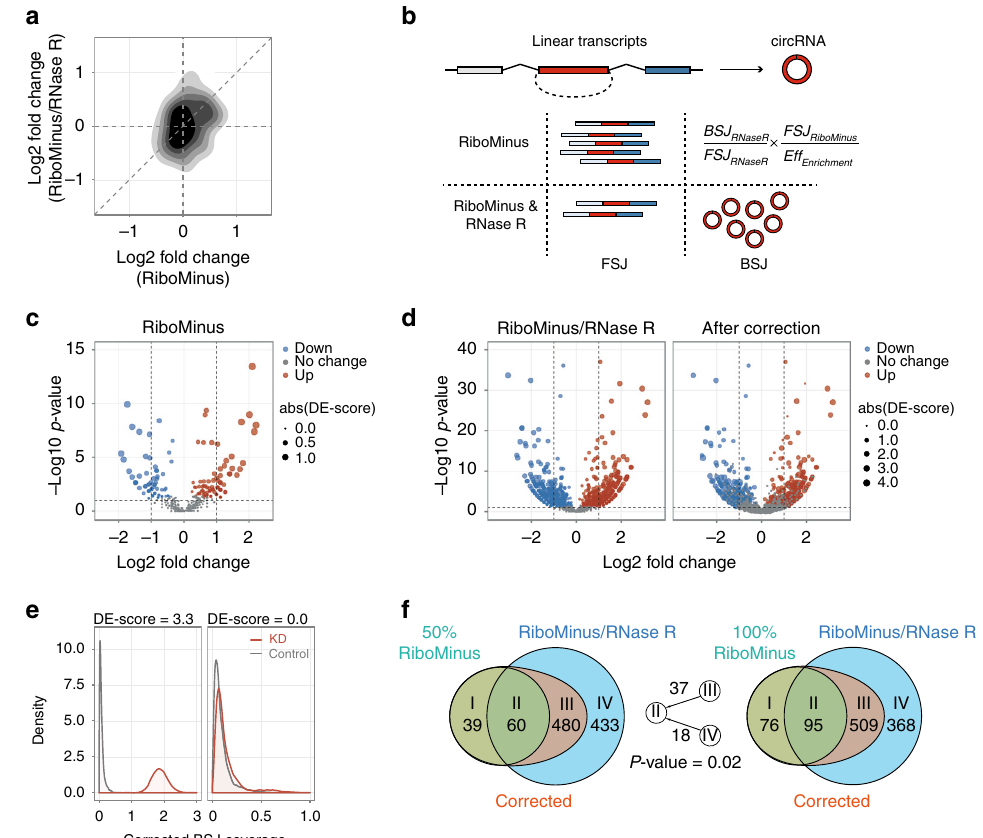
Fig. 4 CircRNA differential expression analysis after RNase R correction. a The correlation of log2 fold change after TRA2B knockdown in RiboMinus and RiboMinus/RNase R-treated libraries. b The schematic work fl ow of RNase R treatment ef fi ciency correction. Firstly, the BSJ and FSJ reads counts from RiboMinus/RNase R sample were obtained. With the posterior distribution of RNase R enrichment coef fi cient, the corrected BSJ reads count in RiboMinus sample can be calculated using the equation shown above. c Volcano plot of − log10 p -value ( y -axis) against log2 fold change ( x -axis) of circRNAs in RiboMinus samples. Size of points indicates DE-score values calculated by CIRIquant. Signi fi cantly upregulated and downregulated circRNAs are labeled in red and blue, respectively. d The volcano plot of circRNAs in RiboMinus/RNase R libraries before and after CIRIquant correction. Red and blue nodes represent up and downregulated circRNAs, respectively, with their node sizes representing DE scores. e CircRNA with relatively higher change in prior probability distribution of the number of BSJ reads will have a more signi fi cant DE score. Red and gray lines represent posterior distribution of corrected circRNA expression values before and after TRA2B knockdown. f Overlap of signi fi cantly differentially expressed circRNAs after and before RNase R correction. The whole and randomly sub-sampled of 50% RiboMinus RNA data are used as control set for RNase R treatment correction in two Venn diagrams. DE-circRNAs are divided into four categories: (I) RiboMinus-speci fi c DE-circRNAs, (II) DE-circRNAs in both RiboMinus and RiboMinus/RNase R-corrected groups, (III) RiboMinus/RNase R-corrected DE-circRNAs, (IV) Dropped DE-circRNAs after RNase R correction. Numbers between the two Venn diagrams show the amount of circRNAs in type III and type IV that can be re-classi fi ed into type II when increasing the data size from 50 to 100%. The type III DE-circRNAs are more likely to be re-classi fi ed into type II than those in type IV ( p -value = 0.02, Chi-squared test), demonstrating the reliability of RNase R correction by